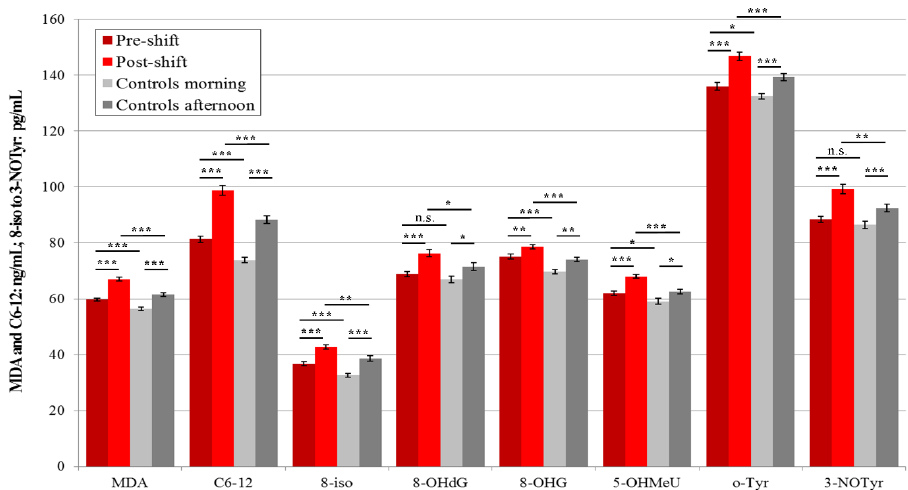
Figure 4. Mean and standard deviation of the levels of eight oxidative stress markers in the plasma of 21 workers (shift = welding or machining) and 18 control subjects in 2018, * p < 0.05, ** p < 0.01, *** p < 0.001, n.s. = not significantly di ff erent, MDA = malondialdehyde, C6-12 = aldehydes C6-C12, 8-iso = 8- iso -prostaglandin F2 α (8-isoprostane), 8-OHdG = 8-hydroxy-2-deoxyguanosine, 8-OHG = 8-hydroxyguanosine, 5-OHMeU = 5-hydroxymethyl uracil, o-Tyr = o -tyrosine, 3-NOTyr =